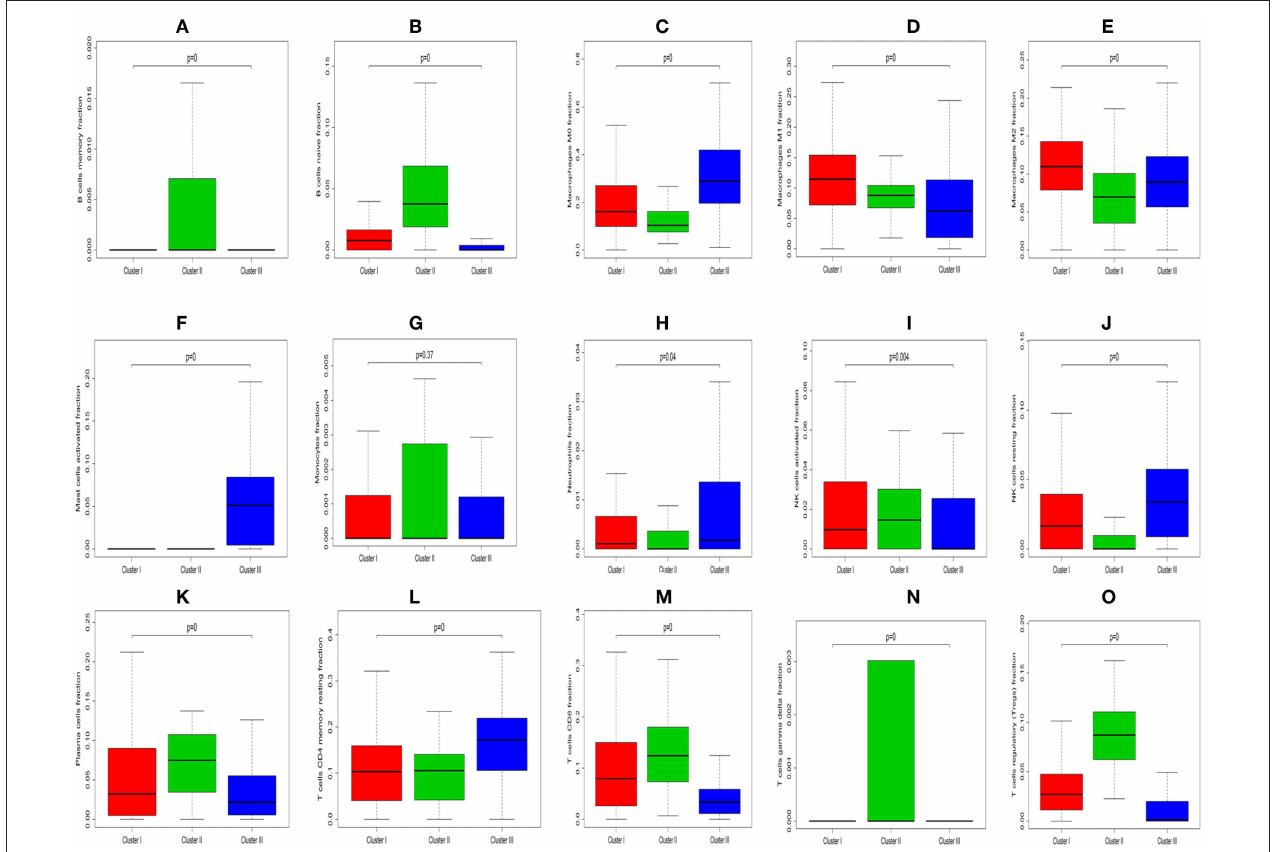
FIGURE 13 | Box plot depicting the association between immune cell subset and three clusters, depicted P -values are from the Kruskal-Wallis tests. (A–O) Is for B cells memory, B cells naïve, Macrophages M0, Macrophages M1, Macrophages M2, Mast cells activated, Monocytes, Neutrophils, NK cells activated, NK cells resting, Plasma cells, T cells CD4 memory resting, T cells CD8, T cells gamma delta, and T cells regulatory (Tregs),